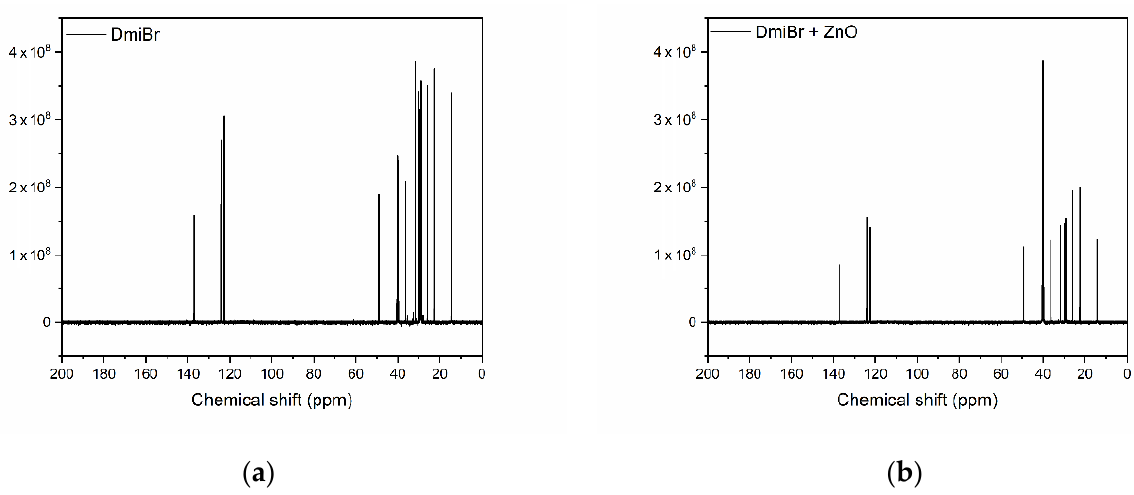
Figure 18. 13 C NMR spectra: ( a ) pure DmiBr; ( b ) 1:2 mixture of DmiBr and ZnO. Table 6. 13 C NMR chemical shifts for pure DmiBr and its mixture with ZnO (1:1).